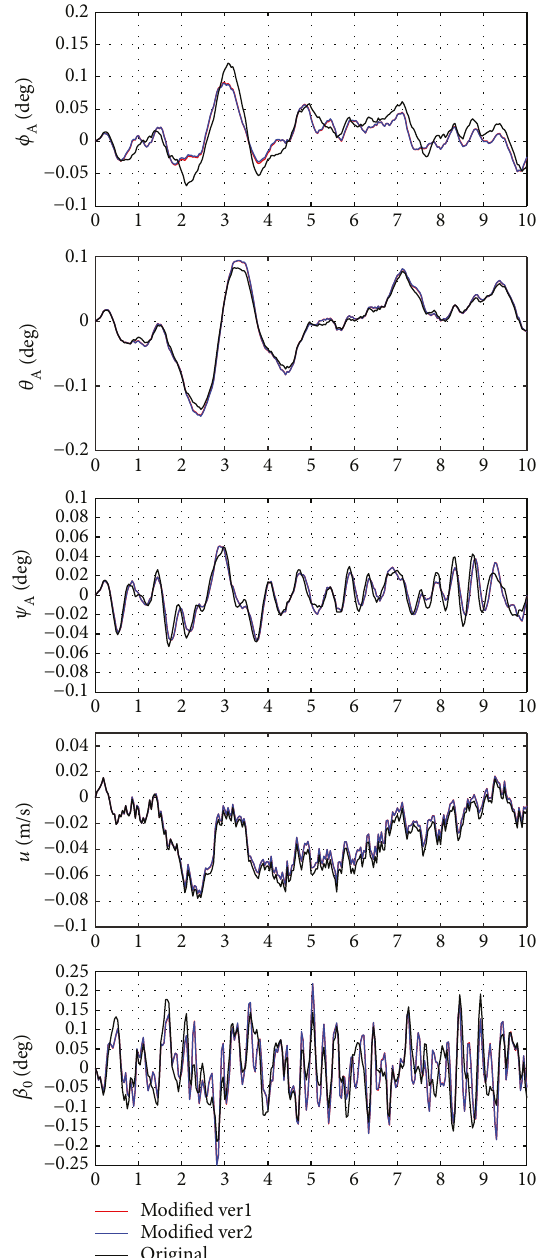
Figure 7: E ff ect of simultaneous variations in blade root chord and blade taper on some states for 40-knot SLFC.